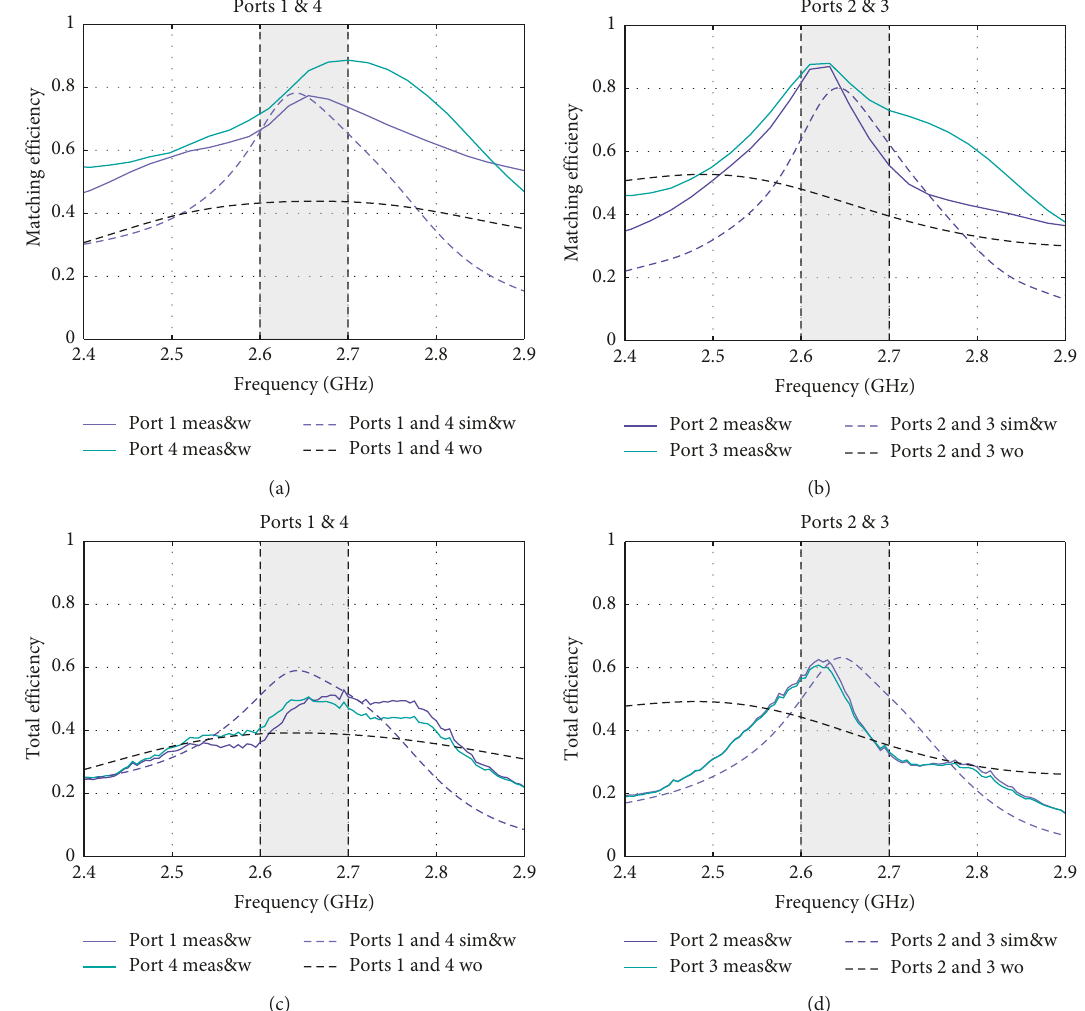
Figure 7: Measured and simulated matching and total efficiencies of the antennas. The simulated results with (sim&w) and without (wo) the DMN and the measured results with (meas&w) the DMN are shown. Table 1: Comparison with other similar works. Simulated Frequency Antennas on Antennas total efficiency Reference (GHz) a single side in (%)